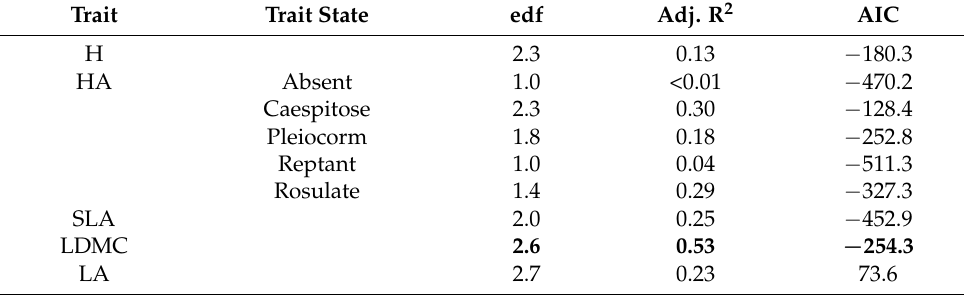
Table 3. Trends of community weighted means under twice-a-year mowing for plant height (H), horizontal architecture (HA), specific leaf area (SLA), leaf dry matter content (LDMC), leaf area (LA), leaf phenology (LP), flowering phenology (FP), clonal spread (CS), clonal position (CP), and Grime’s CSR plant strategy. Significant relations ( p -value < 0.05) are indicated in bold. AIC values are referred to REML (restricted maximum likelihood). Effective degrees of freedom (edf) are a measure of the shape of the curves (with 1 completely linear; 2 completely quadratic; 3 completely cubic).